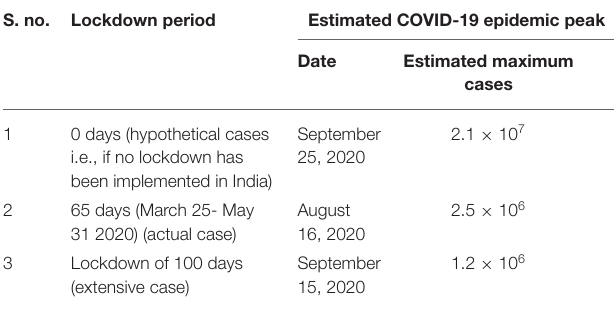
TABLE 2 | COVID-19 epidemic peak prediction using SEIRD model in India under lockdown effect. S. no. Lockdown